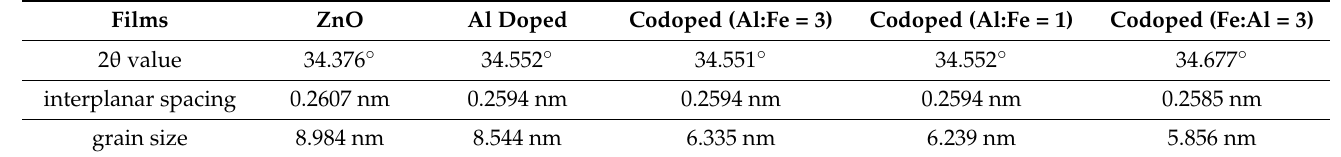
Table 2. Atomic content of each element in codoped (Al:Fe = 1) film.